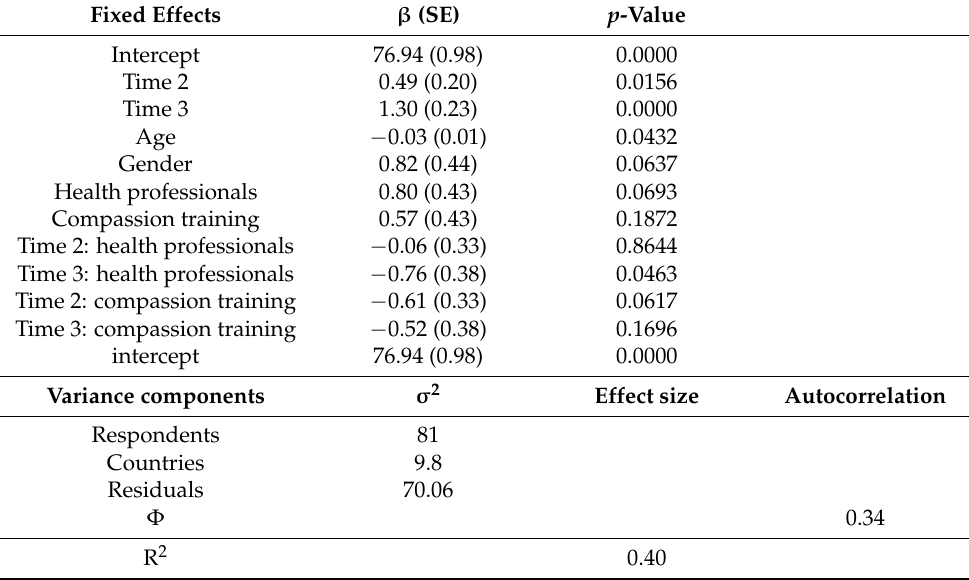
Table 2. Estimates of the final model for compassion for